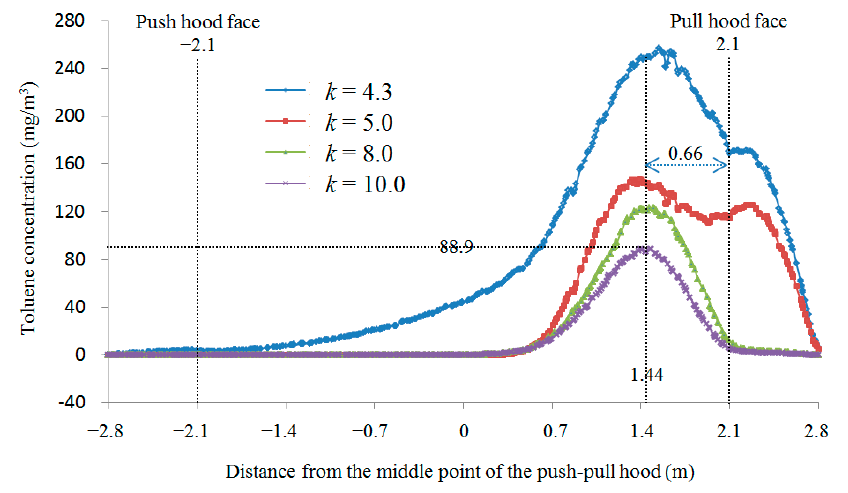
Figure 5. Toluene concentration at respiratory zone locations for different k values at L / a = 6.